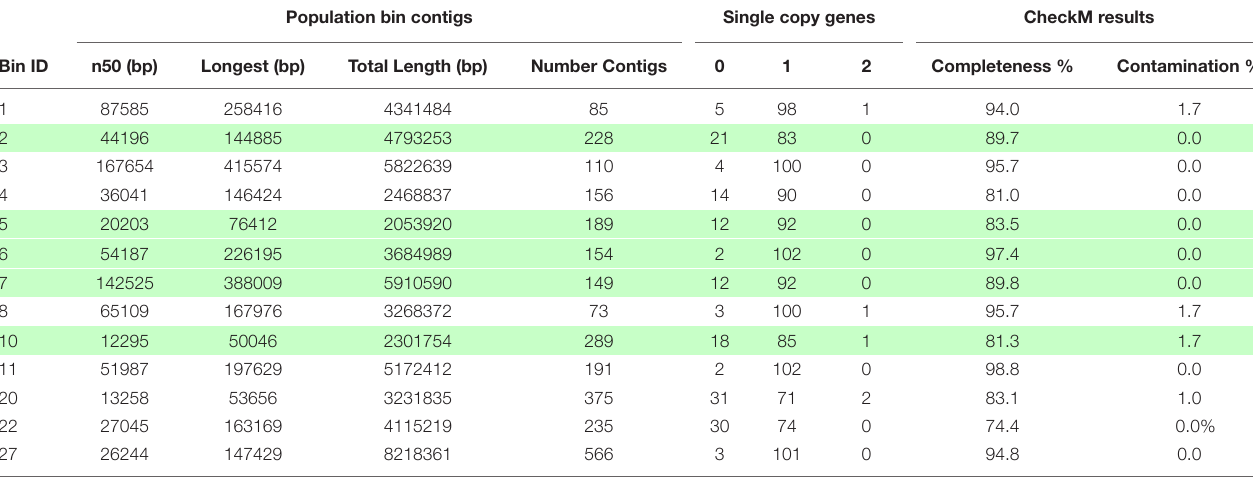
TABLE 1 | Summary statistics for the most complete population bins.